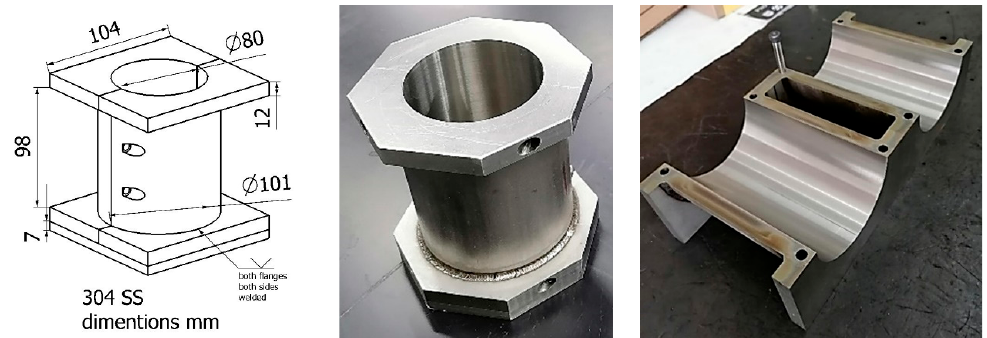
Figure 1. Bipartite stainless steel metallic mold.